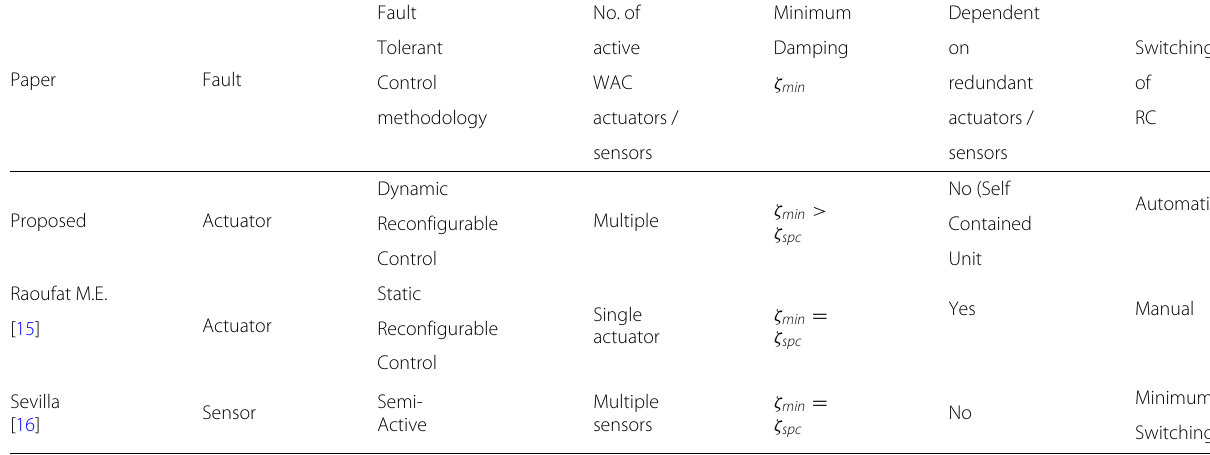
Table 4 Comparison of results with other FTC methods in wide area control and damping of PS